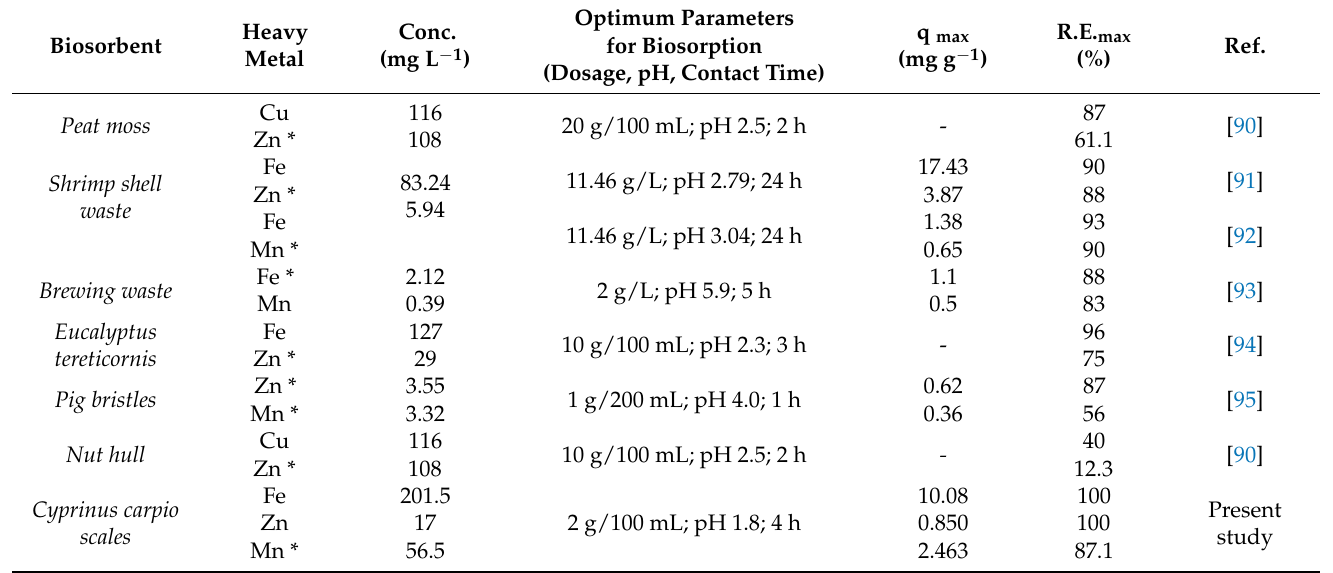
Table 5. Comparison of the maximum adsorption capacity and removal efficiency of various biosor- Table 4. Kinetics model parameters and the regression coefficients for metals adsorption by powder bents used for the removal of Fe, Zn, and Mn ions from AMD Cyprinus carpio scales.